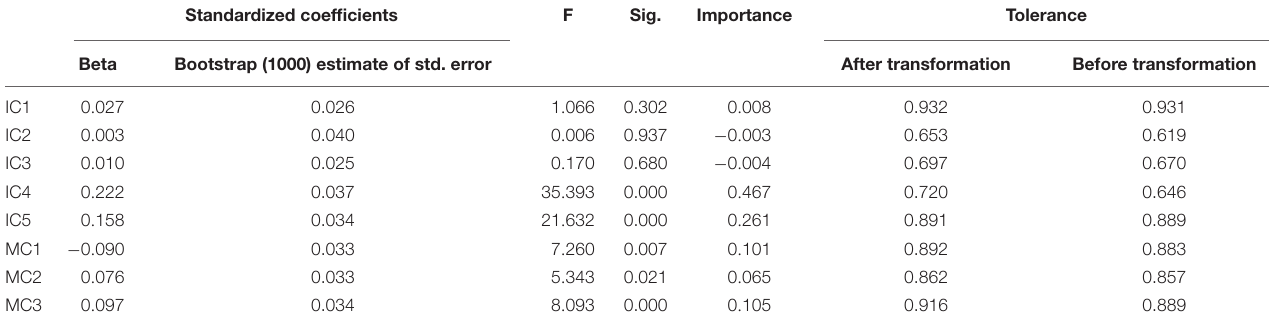
TABLE 6 | Summary of optimal scaling regression analysis